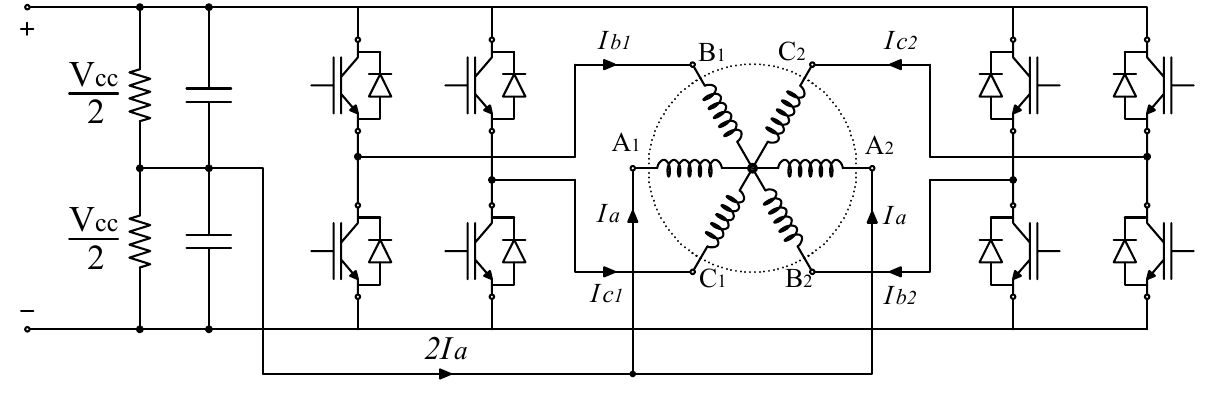
Figure 5. Proposed driving